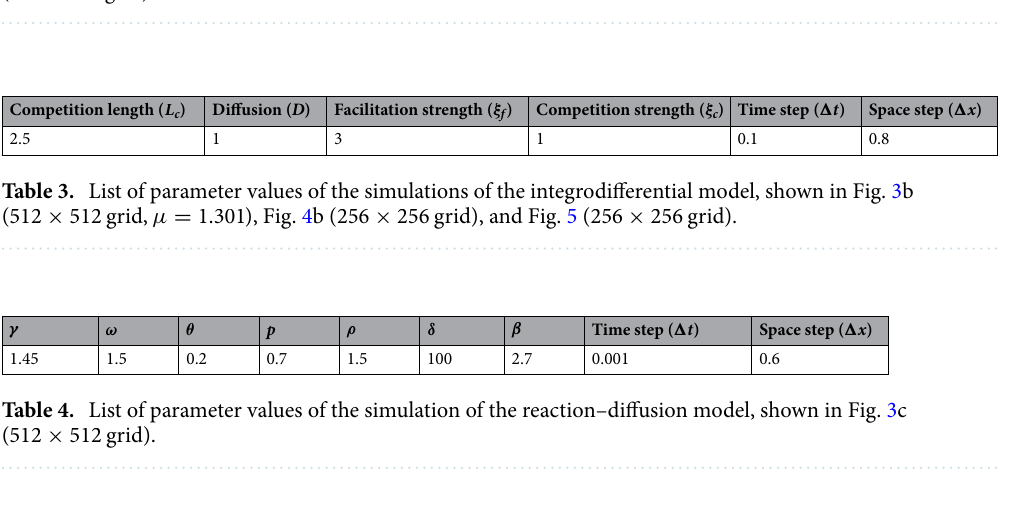
Table 2. List of parameter values of the simulations of the non-variational Swift–Hohenberg equation, shown in Fig. 3a ( 200 × 200 grid, η = 1.01 ), Fig. 4a ( 120 × 120 grid, [i, ii, iii] with space step (cid:31) x = 0.5 ), and Fig. 6 ( 120 × 120 grid).